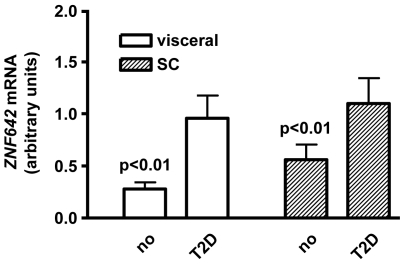
Expression of ZNF642 in adipose tissue of human individuals with (T2D) and without (no) type 2 diabetes.mRNA levels were determined by qRT–PCR in subcutaneous (sc) and visceral adipose tissue from 67 controls and 31 individuals with type 2 diabetes.